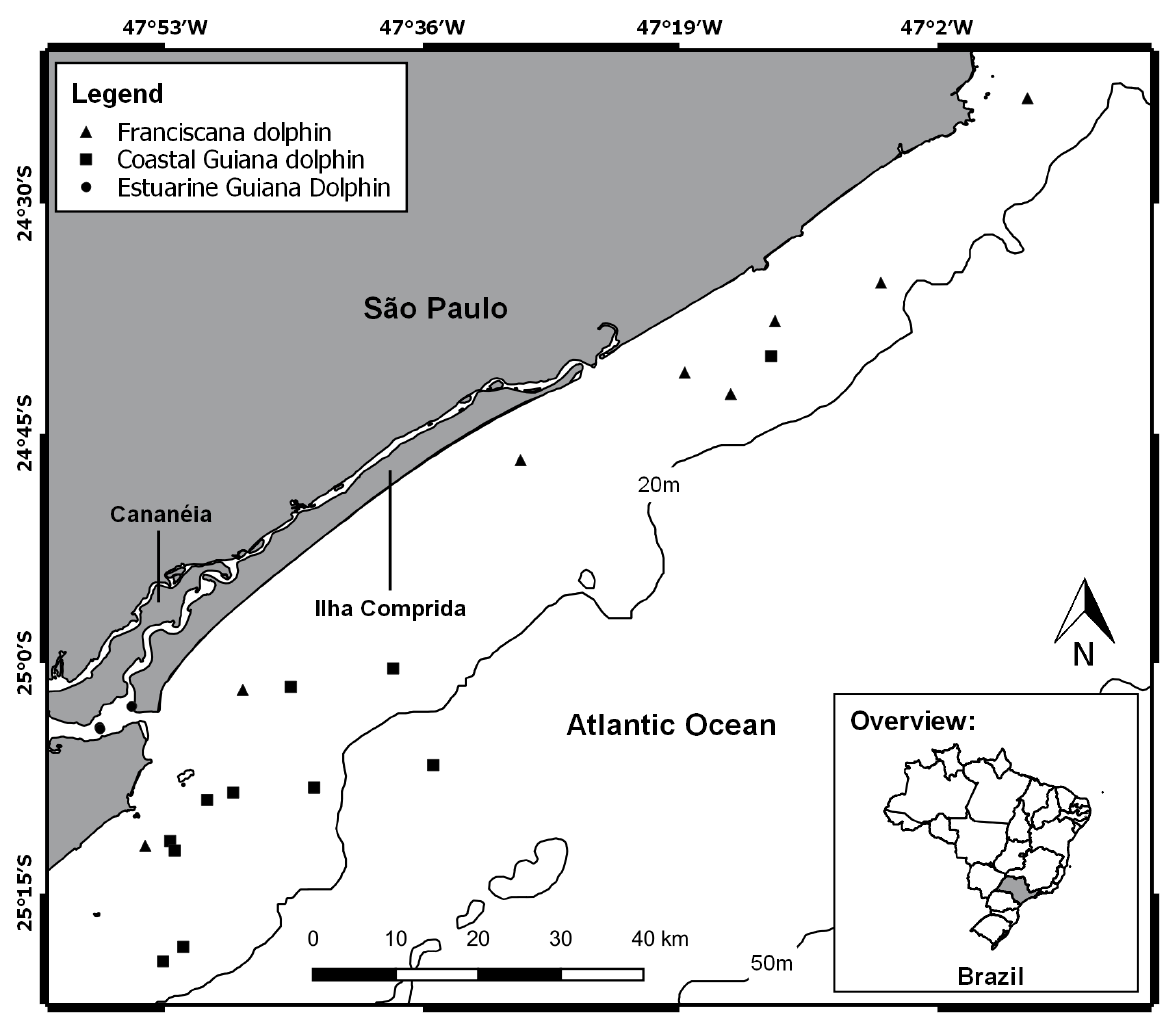
Figure 1. Map of the study area showing the southern coastal region of São Paulo state, southeastern Brazil. Dots indicate the exact locations where dolphins were